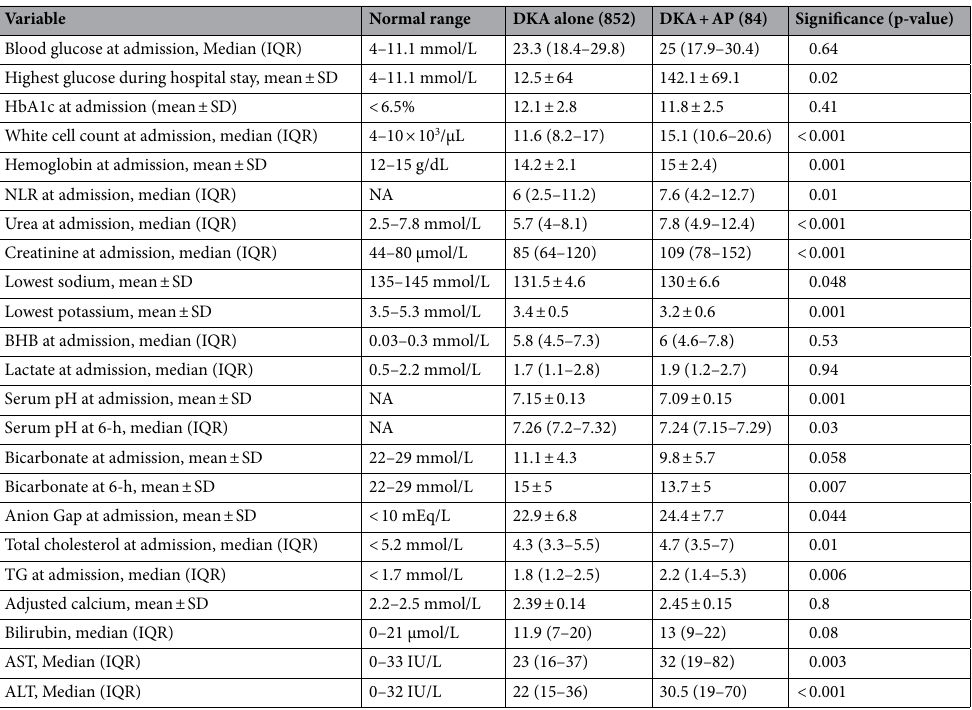
Table 2. Comparison of laboratory parameters between DKA versus DKA with AP patient groups. DKA Diabetic ketoacidosis, AP acute pancreatitis, SD standard deviation, IQR interquartile range, hbA1c glycated hemoglobin, NLR neutrophil to lymphocyte ratio, BHB beta-hydroxybutyrate, LDL low-density lipoprotein, TG triglyceride, AST aspartate aminotransferase, ALT alanine aminotransferase.